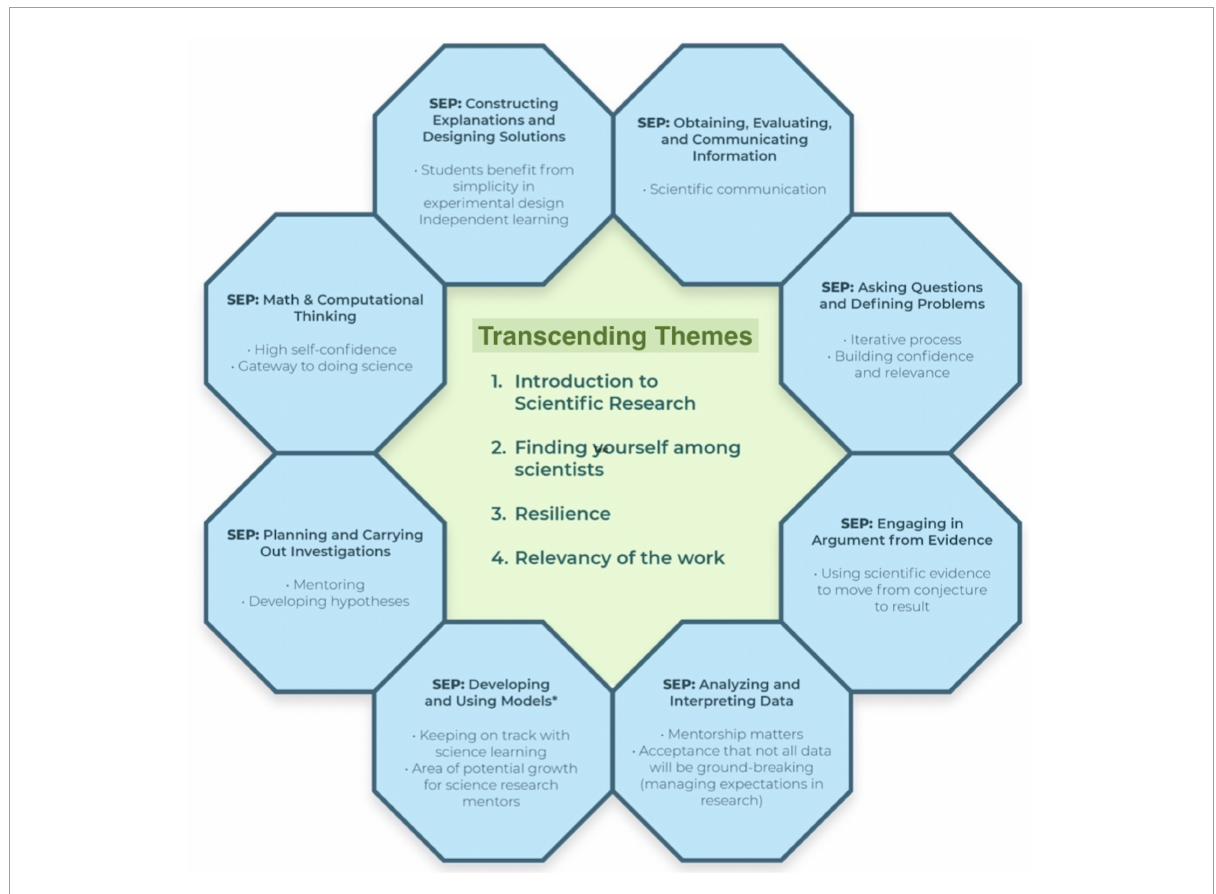
FIGURE2 Science and engineering practice (SEP) specific and transcending themes.